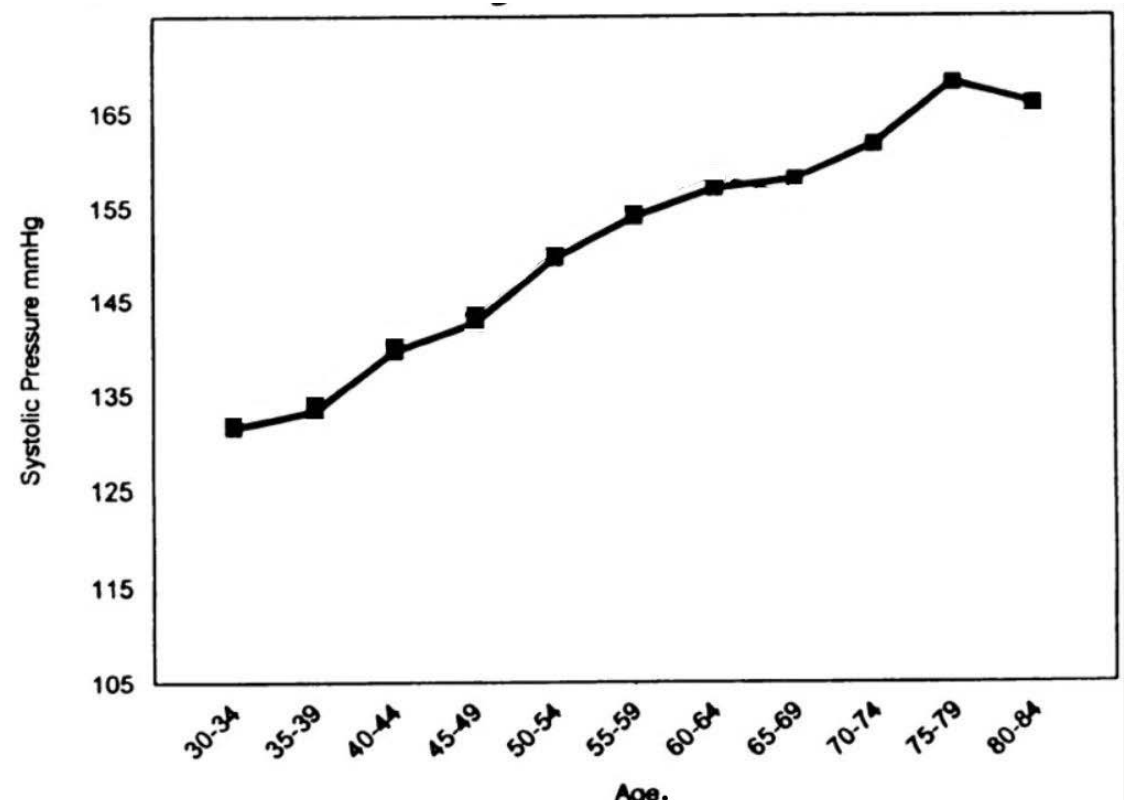
Figure 1. Normal increase in systolic blood pressure with age Overall data from the Framingham study, redrawn from Figure 1 in Franklin et al.